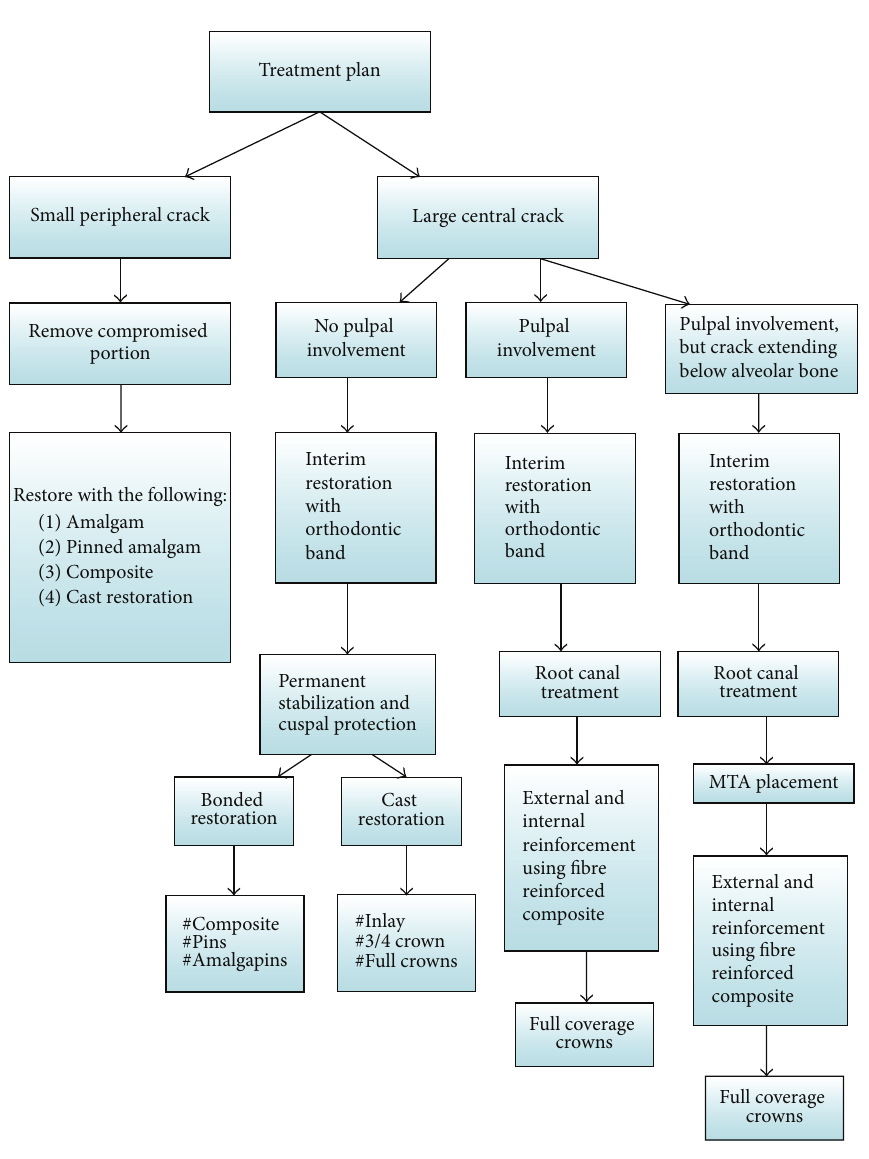
Figure 1: Treatment protocol for longitudinal fracture of